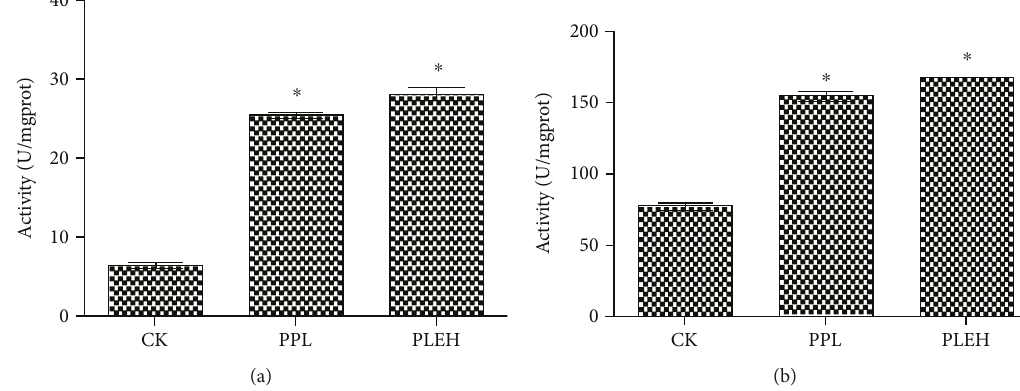
Figure 8: Comparison of choline acetyltransferase (ChAT) activities for hippocampi (a) or palliums (b) from suckling o ff spring among the negative control (CK) group, pregnancy and lactation sialic acid control (PPL) group, and pregnancy and lactation EBN high-dose (PLEH) group. Signi fi cant di ff erences were indicated by the symbol “ ∗ ” for each group ( P < 0 05 ).